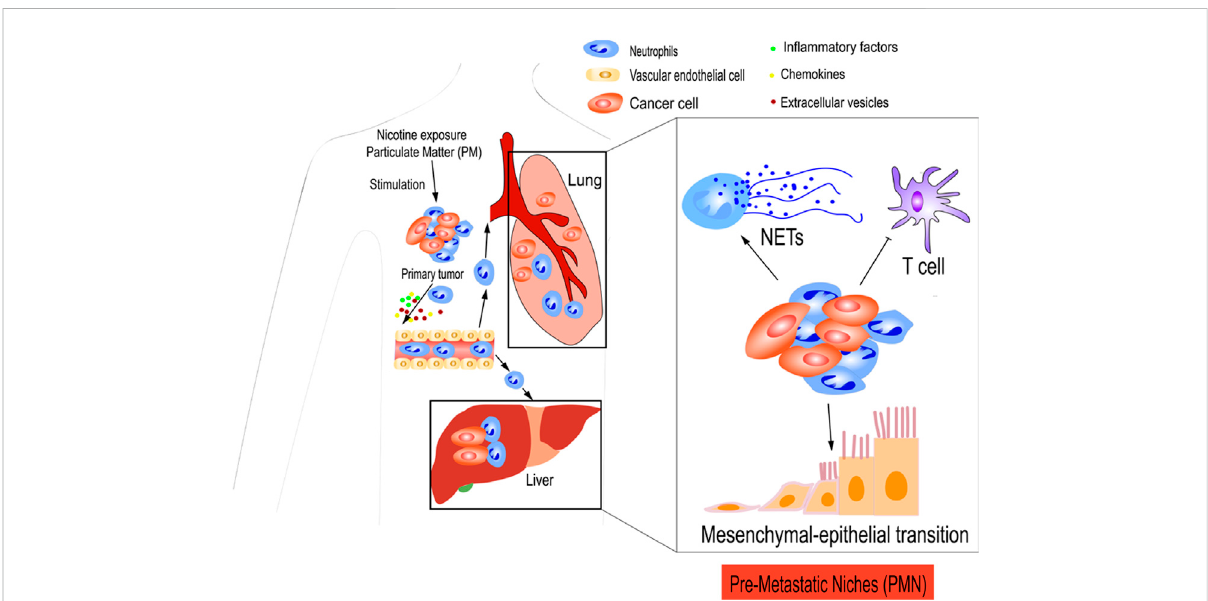
FIGURE 3 TANs prepare pre-metastatic niches (PMNs) for tumor cells. Primary tumors secretedvariouscytokines, chemokines, and in fl ammatory factors toestablishPMN. CXCL12,CXCL1,andCXCL3fromtumorscausetheaggregation ofimmunosuppressive neutrophils inthePMN,whichresultinthe suppression of antitumor immunity of T cells. Neutrophils recruited to the PMN may release NETs that facilitate the trapping of cancer cells. Extracellularvesicles(EVs)haveanimportantroleintheformationofthePMN,whichfacilitatesmetastasis.Furthermore,nicotineexposureand particulate matter (PM) can also induce neutrophil recruitment and PMN formation. Nicotine exposure promotes the MET, thereby restoring some epithelial features and contributing to early colonization of the